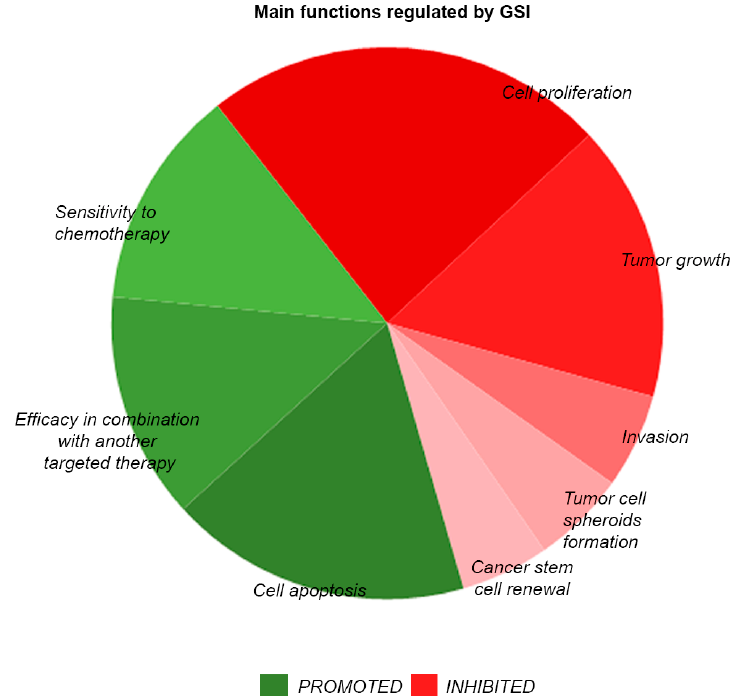
Figure 3. Functional effects of gamma secretase inhibitors. The pie chart represents the main biological activities promoted or inhibited by GSI, based on the prevalence of their report in literature (approx. 450 Pubmed-indexed research papers related to the use of GSI were individually analyzed).